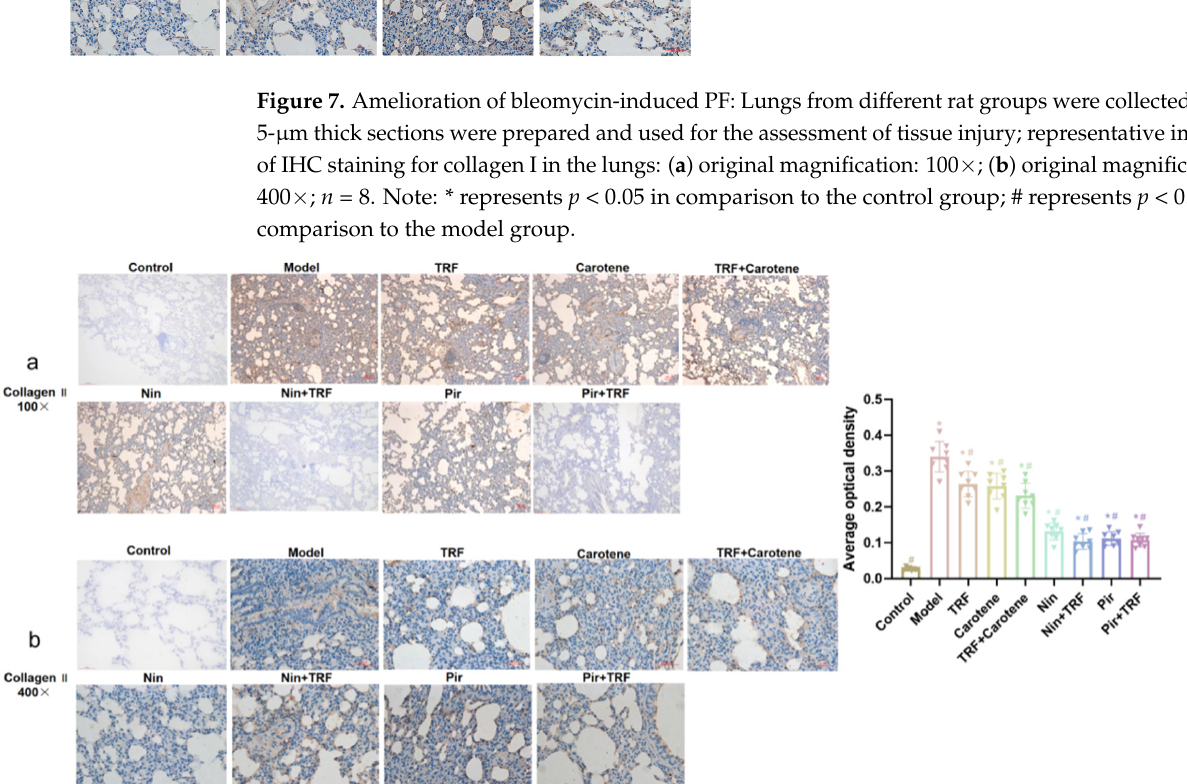
Figure 8. Amelioration of bleomycin-induced PF: Lungs from different groups were collected, and 5- µ m thick sections were prepared and used for the assessment of tissue injury; representative images of IHC staining for collagen II in the lungs: ( a ) original magnification: 100 × ; ( b ) original magnification: 400 × ; n = 8. Note: * represents p < 0.05 in comparison to the control group; # represents p < 0.05 in comparison to the model group.